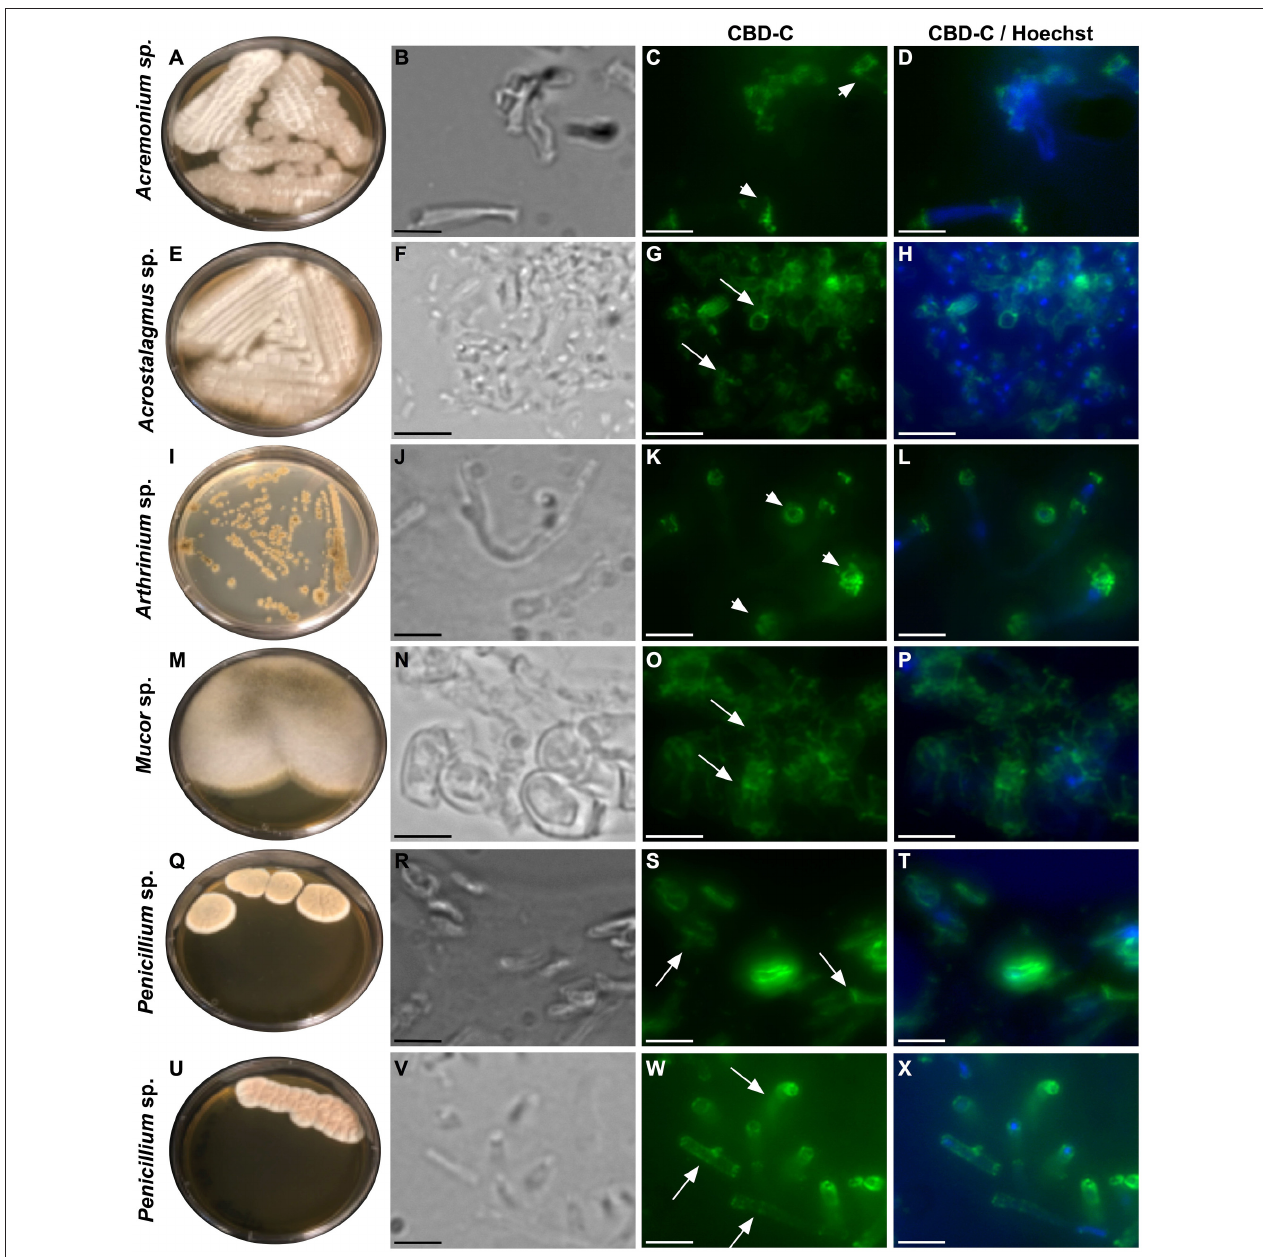
FIGURE 1 | Immunofluorescence with the Fc-CBD-C probe on fungal sections. Several species of fungi, including: Acremonium sp., Acrostalagmus sp., Arthrinium sp., Mucor sp., and Penicillium spp., were isolated from Ciona gut and grown on YPD agar plates (A,E,I,M,Q,U) . Immunofluorescence staining, using the Fc-CBD-C probe and detected with a fluorescent secondary antibody (Alexa Fluor 488), on OCT-embedded and cryo-sectioned fungal isolates, indicates that chitin molecules are distributed in the whole cell wall of most of the fungi analyzed ( G,O,S,W, arrows). In two fungal species, the Fc-CBD-C probe detects chitin localized in specific regions of the fungal cell wall ( C,K , arrowhead). (B,F,J,N,R,V) are brightfield images of fungal sections; (D,H,L,P,T,X) represents merged images of the Fc-CBD-C probe (green) and nuclear staining with Hoechst (blue). Scale bars: (B–D,J–L,R-T,V–X) , 5 µ m; (F–H, N–P) 10 µ m.